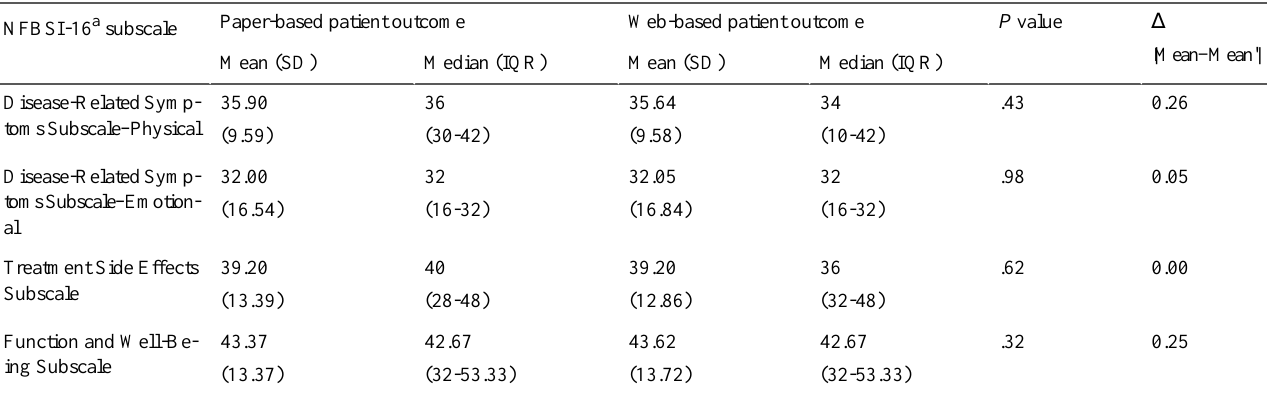
Table 3. Parallel test-retest reliability of subscales (Wilcoxon